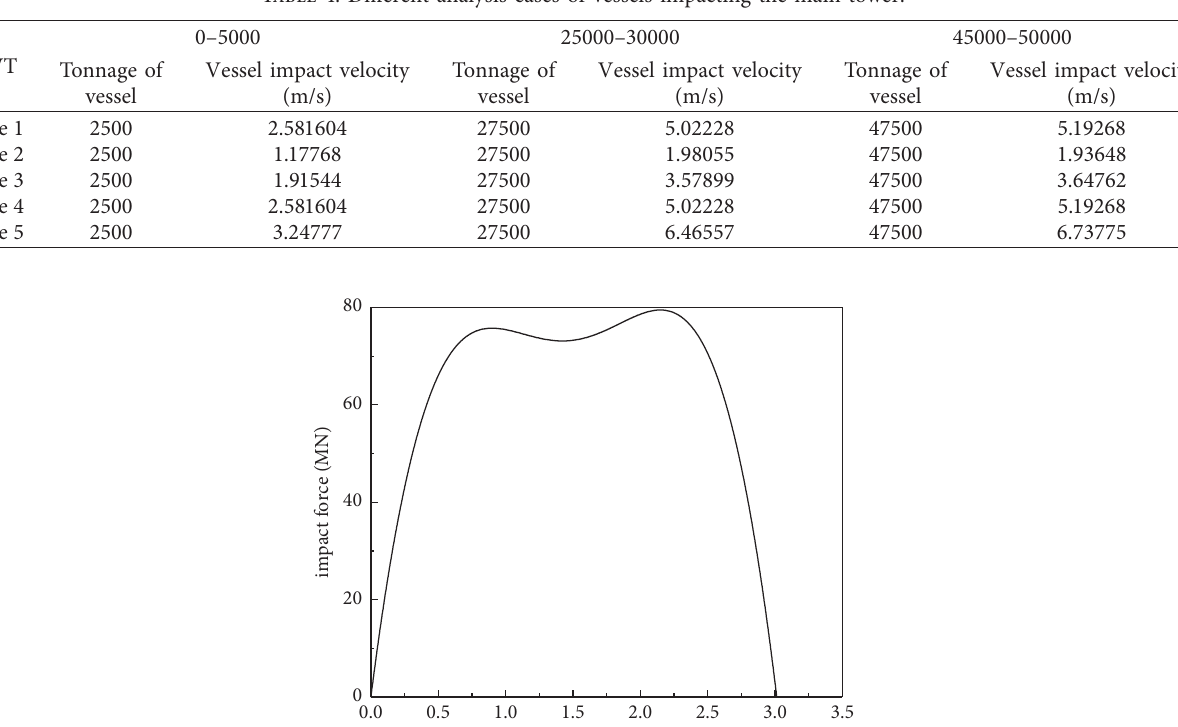
Table 4: Different analysis cases of vessels impacting the main tower.